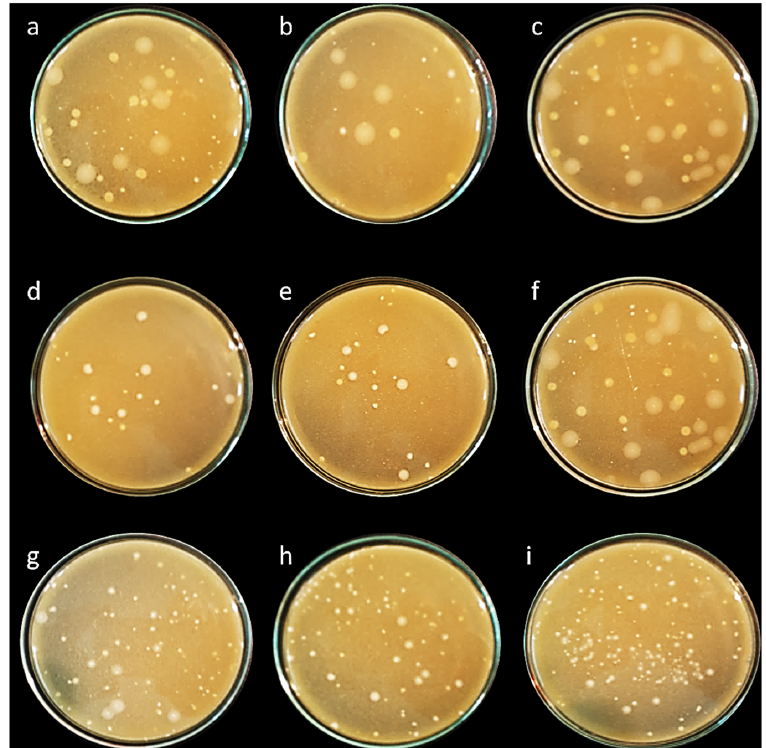
Figure 5. Bile salt hydrolase’s activity assay of isolated lactic acid bacteria. Activated LAB isolates were inoculated and plated onto MRS and M17 agar containing tauro-deoxycholic acid. The plates were incubated anaerobically or aerobically at 37 °C for 48 h. Bile salt hydrolase activity was indicated by deoxycholic acid precipitate around the colonies. ( a ) E. faecalis ASO44; ( b ) E. faecium ASO292; ( c ) L. delbrueckii ASO100; ( d ) L. lactis ASO26; ( e ) L. plantarum ASO50; ( f ) L. casei ASO53; ( g ) L. rhamnosus ASO20; ( h ) L. gasseri ASO25 ( i ) L. paracasei ASO3. a,b,c,d Estimates with the same letters are not significantly different ( p > 0.05) among different iso- lates for the same column. ND stands for Non-Detect. Table 5. Antibiotic resistance of isolated lactic acid bacteria.